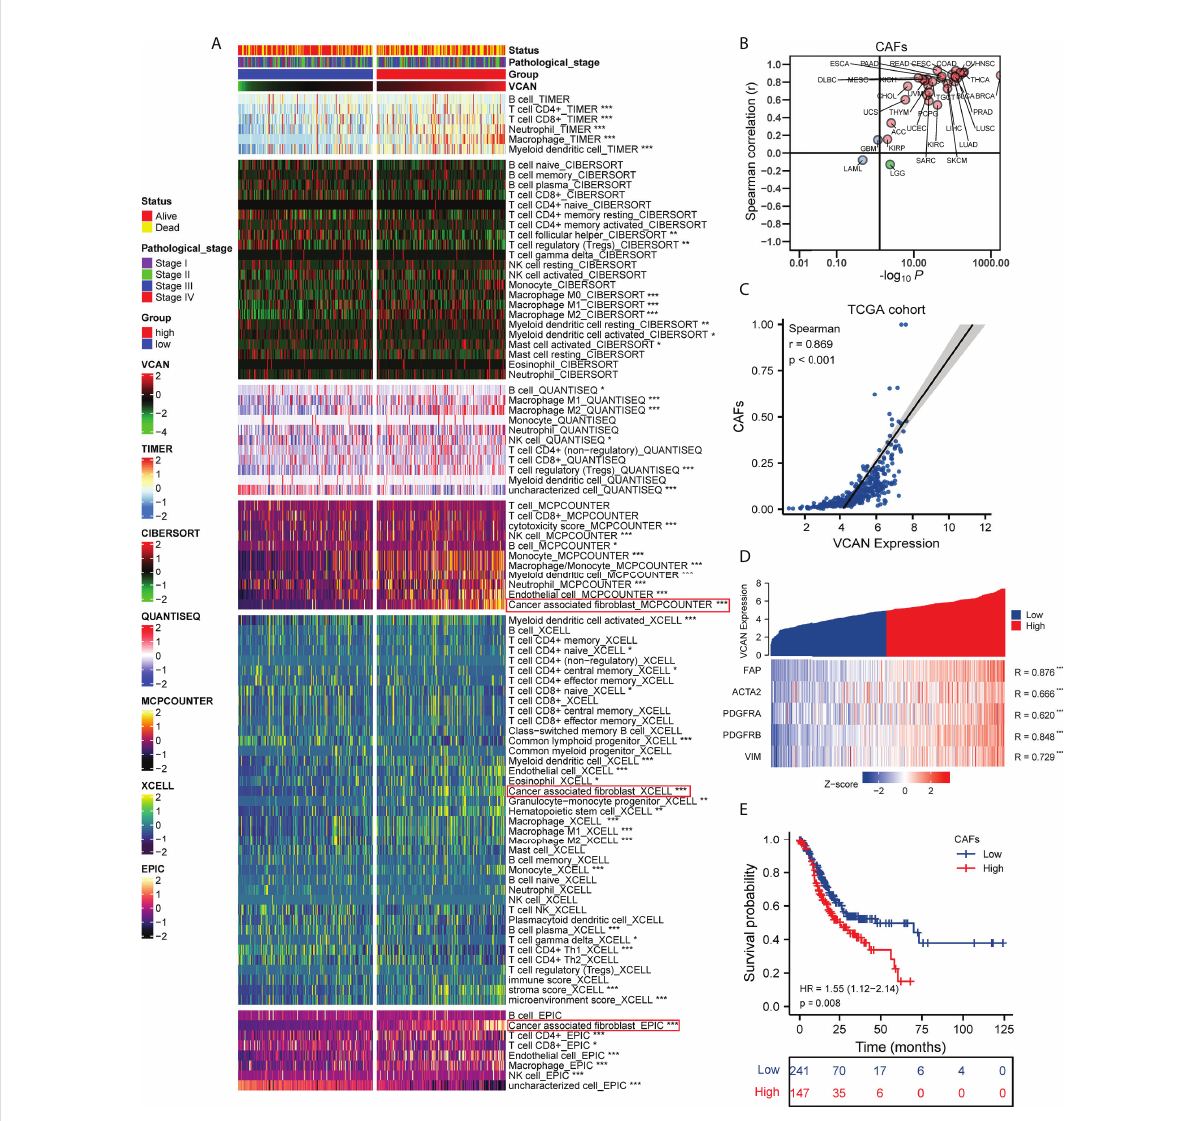
FIGURE 5 The correlation between VCAN expression and the tumor microenvironment. (A) The correlation between VCAN expression with the in fi ltration of immune cells and stroma cells in tumor microenvironment (TCGA cohort). (B) The correlation between VCAN expression with the in fi ltration of CAFs in human pan-cancer (Pan-cancer Atlas, TCGA). (C) The correlation between VCAN expression with the in fi ltration of CAFs in patients with GC (TCGA cohort). (D) The correlation between VCAN expression with the expression of CAFs markers in patients with GC (TCGA cohort). (E) Kaplan – Meier curves of OS of low and high group strati fi ed by the CAFs in fi ltration in patients with GC (TCGA cohort). *p < 0.05, **p < 0.01, and ***p < 0.001. GC: gastric cancer; CAFs: cancer associated fi